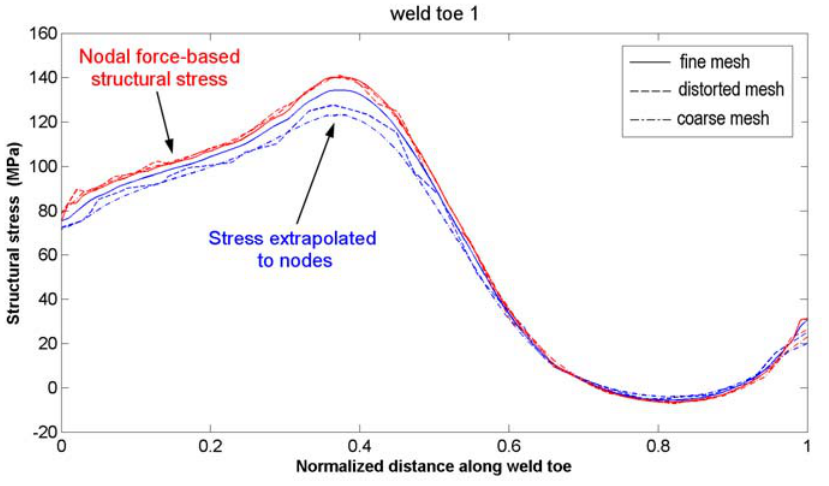
Figure 5: Comparison of the normal stress to the weld calculated from nodal stresses and the structural stress obtained from nodal forces (toe 1 in Fig.